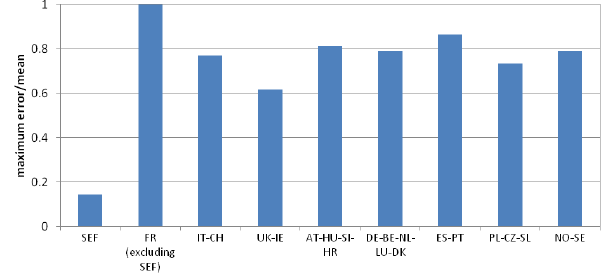
Figure A1. Maximum relative difference between the a posteriori emissions obtained from the inversions using four different scaling factors applied to the a priori emission field for the year 2008. SEF,